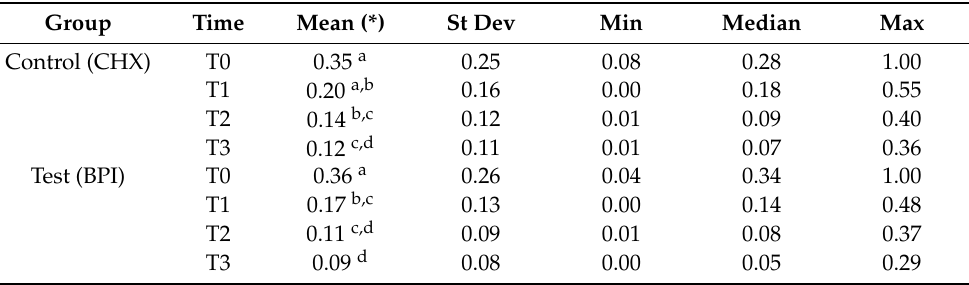
Table 4. Descriptive statistics of bleeding on probing